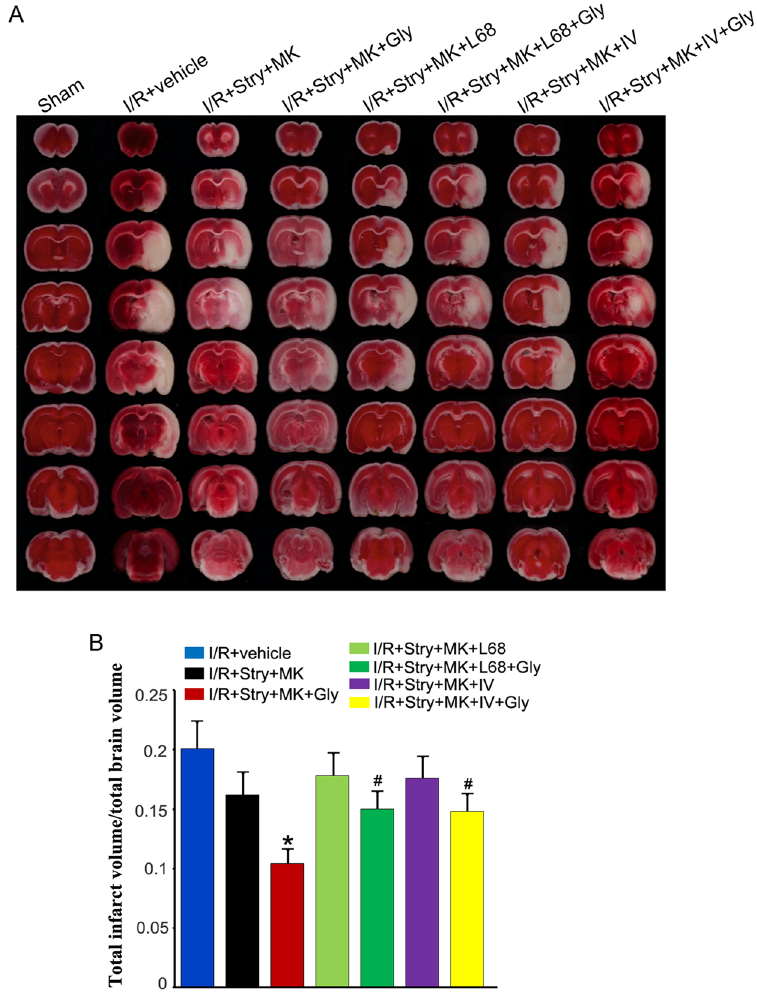
Figure 3. Glycine-GluN1 binding antagonist and Akt inhibitor attenuate the effect of glycine in reducing the infarct volume after glycine receptors and the channel activity of NMDARs are inhibited. ( A ) Sample images of TTC strained-brain sections collected at 24 h after ischemia onset. Glycine (100 µ g/100 g, icv) was administered at 3 h following I/R. Glycine-GluN1 binding antagonist L-689560 (L68; 0.1 mg/100 g, ip) or Akt inhibitor IV (100 µ M, 2 µ l, icv) is injected with MK-801 and strychnine at 30 min before glycine injection. ( B ) Summarized quantification data indicate that glycine-GluN1 binding antagonist and Akt inhibitor treatment attenuate the effect of glycine in reducing the infarct volume after glycine receptors and NMDARs are inhibited (n = 6, ANOVA test, * P < 0.05 vs. I/R + Stry + MK; # P < 0.05 vs. I/R + Stry + MK + Gly). Stry: Strychnine; Gly: glycine; MK: